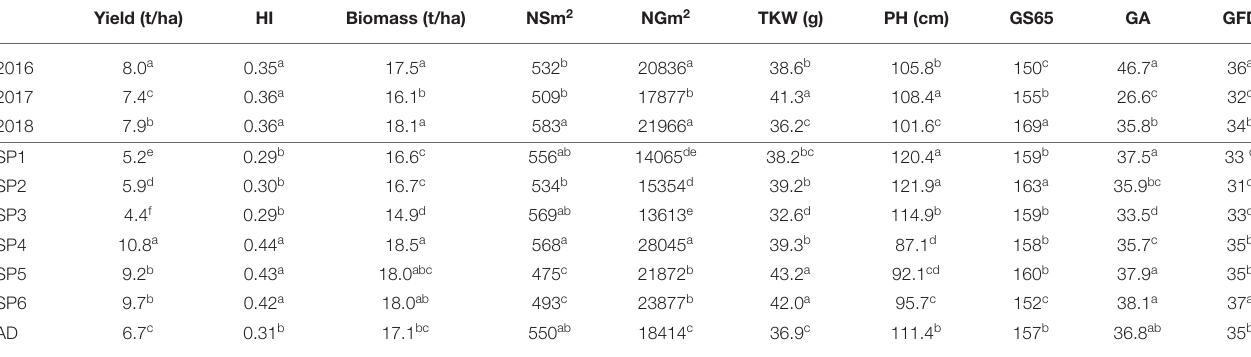
TABLE 5 | Mean values of grain yield, harvest index (HI), biomass, number of spikes per unit area (NSm 2 ), number of grains per unit area (NGm 2 ), thousand kernel weight (TKW), plant height (PH), green area (GA), number of days from sowing to anthesis (A) (GS65), and grain filling duration (GFD, GS87) in a set of 170 landraces and 184 modern cultivars of bread wheat for each growing season and genetic subpopulation. Yield (t/ha) HI Biomass (t/ha) NSm 2